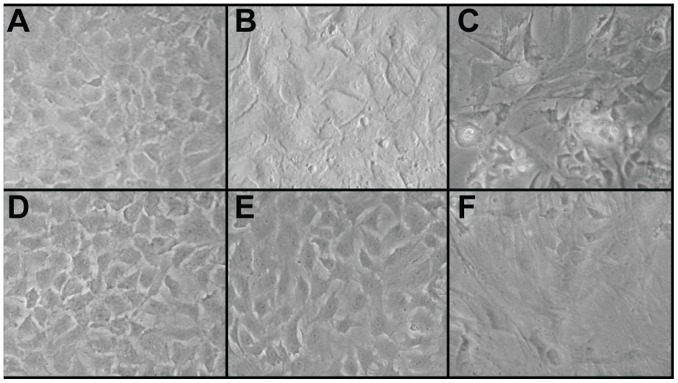
Cell Morphology in Monolayer.Morphology at confluence, prior to passaging at P1 (a–c) and P3 (d–f). Cells expanded in CHG with bFGF supplementation exhibited a rounded, cobblestone morphology upon confluence (a,d). Cells expanded in CHG with TFP (TGF-β1, bFGF, and PDGF) supplementation exhibited a polygonal, compact morphology upon confluence (b,e). Cells expanded in tranditional expansion medium containing 10% FBS exhibited a flattened, elongated cell morphology upon confluence (c,f).